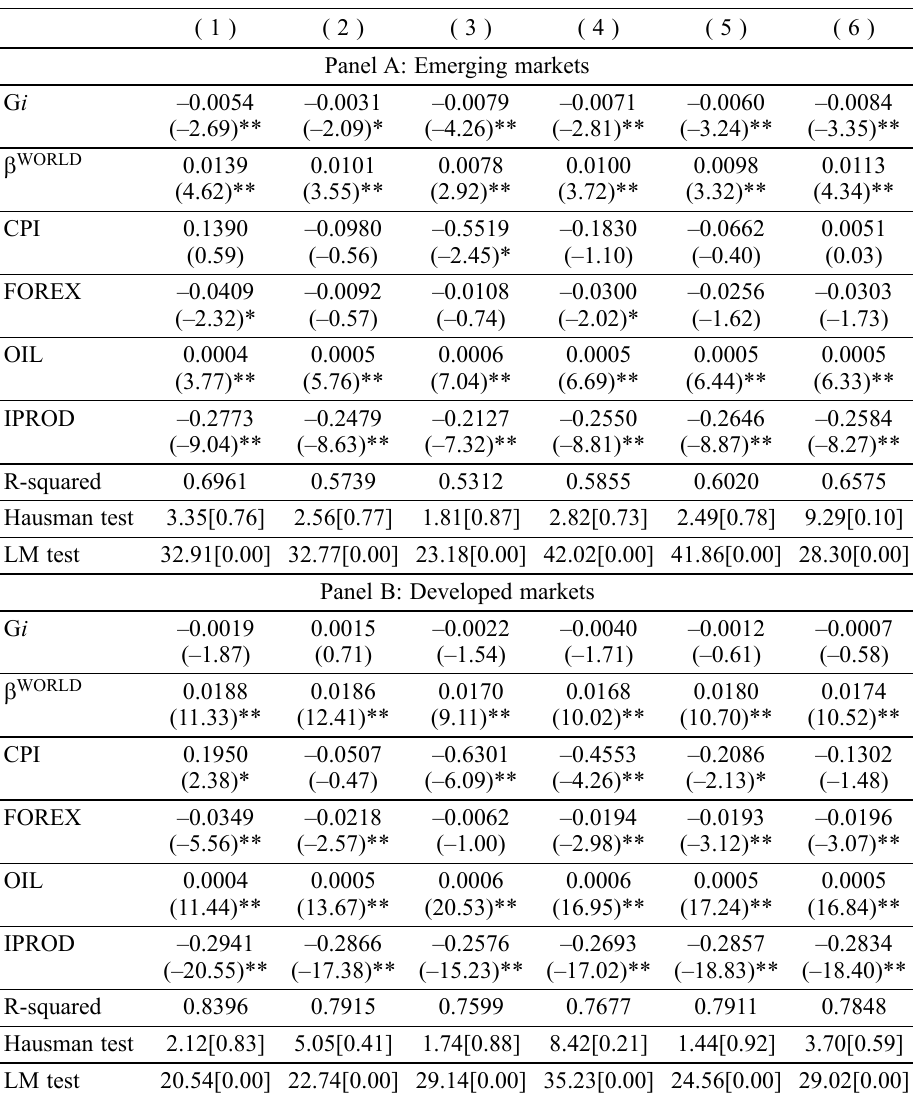
Table 3. Panel regression of equity market risk on governance variables and global risk factors